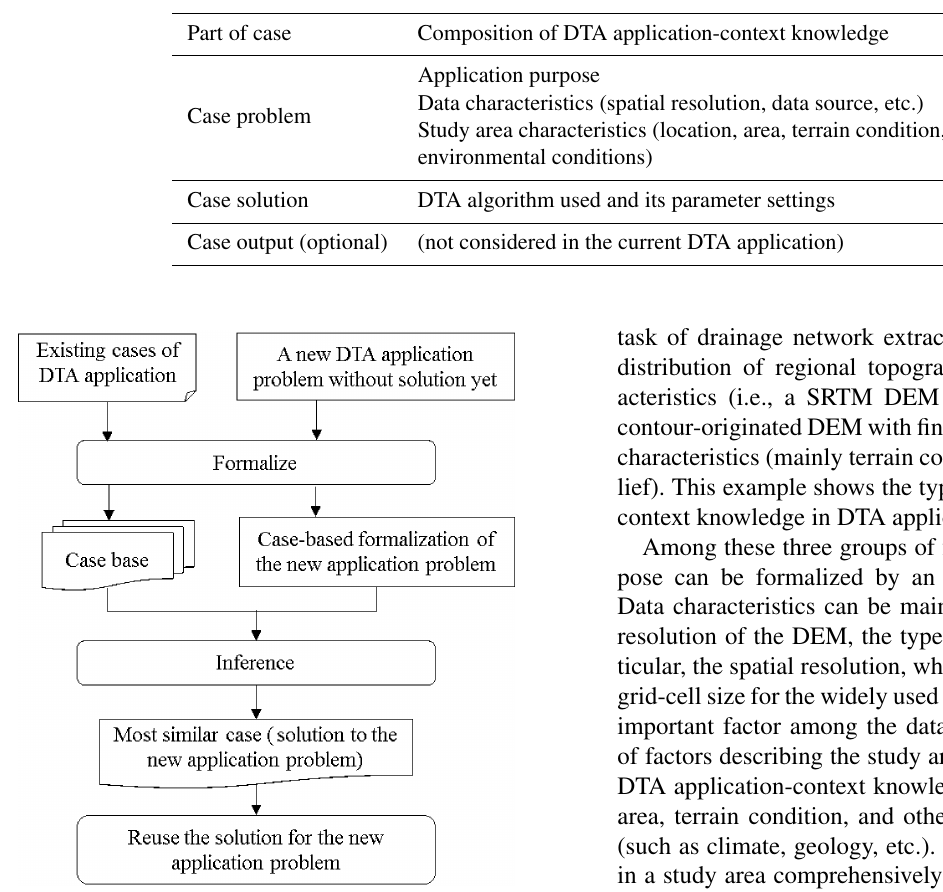
Figure 1. Structure of the case-based formalization and reasoning method for DTA application-context